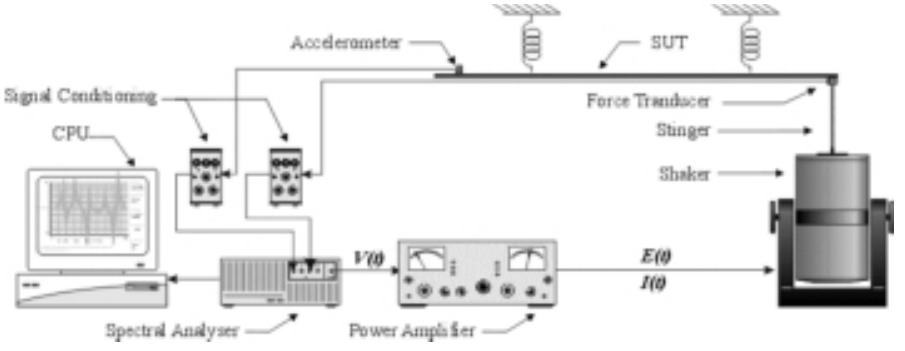
Fig. 9. Test on free – free steel beam.